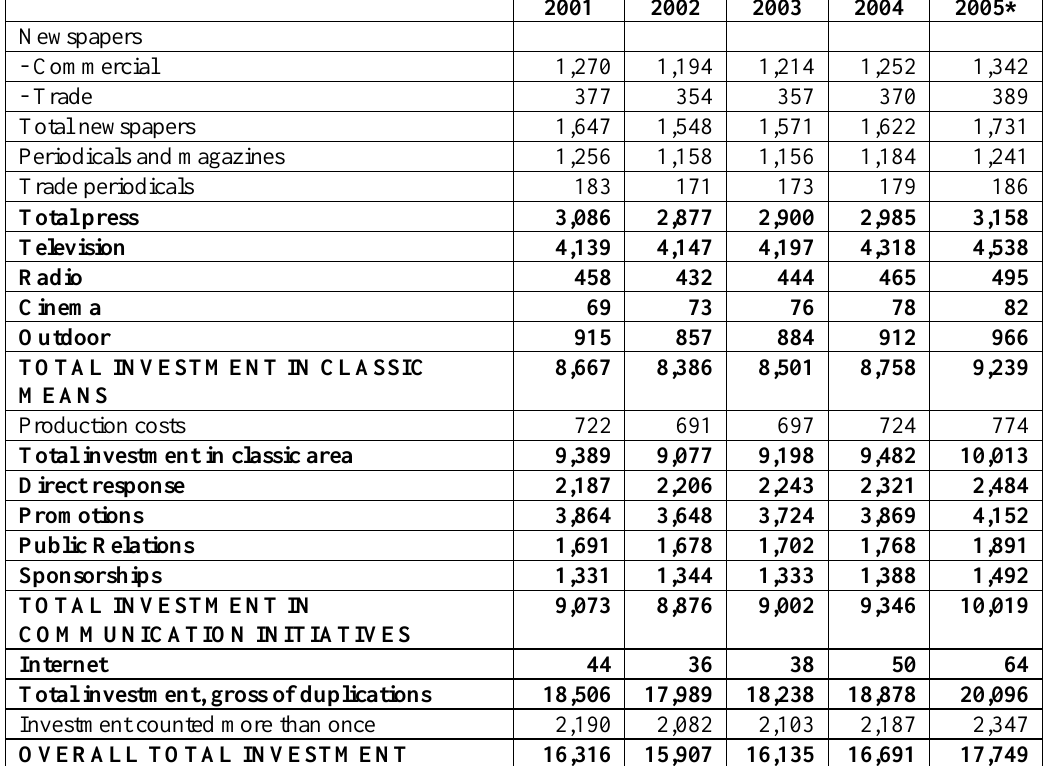
Figure 10: Breakdown of Communication Investments in Italy (in Thousands of